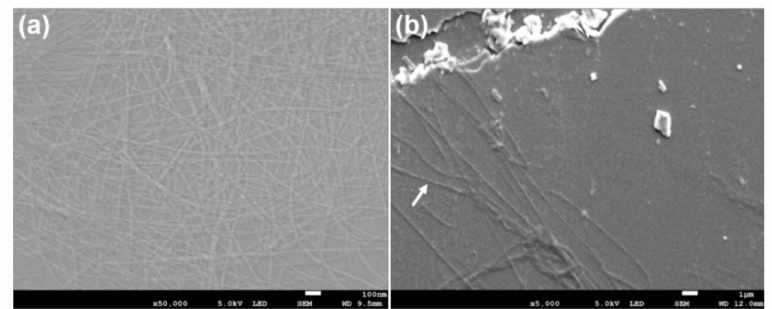
Figure 6. SEM images of ( a ) WPI fibrils and ( b ) collagen fibrils on glass substrates. Arrow indicates a collagen fibril. Scale bar: ( a ) 100 nm and ( b ) 1 µ